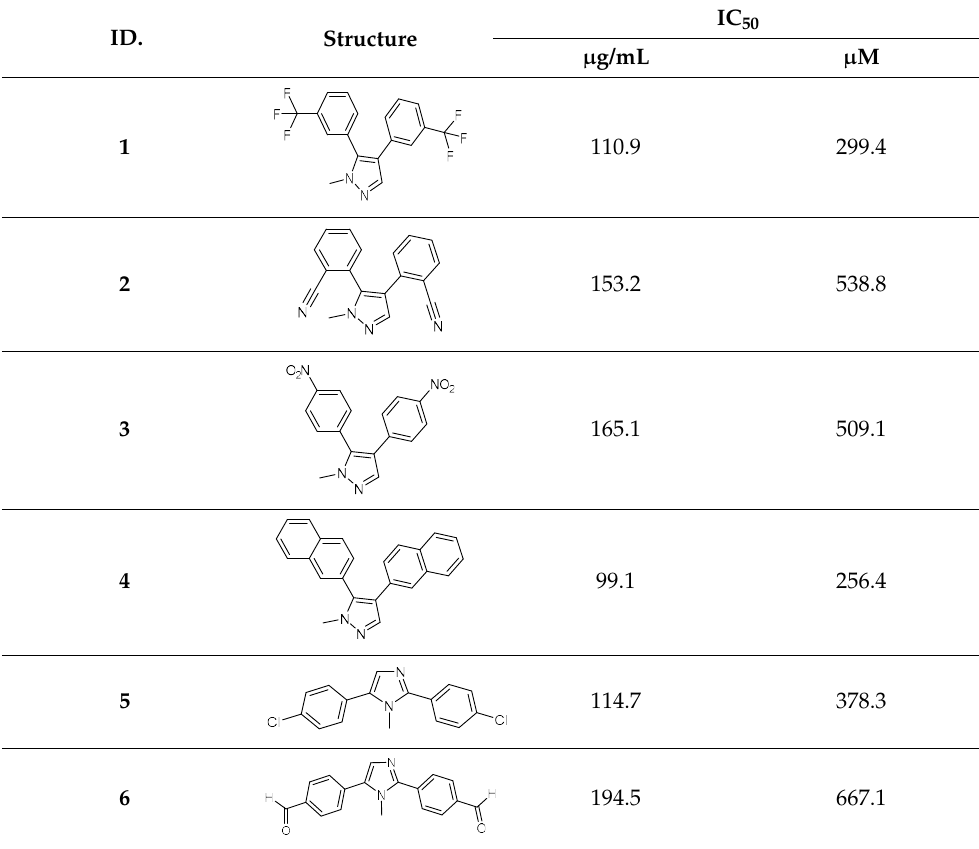
Table 2. IC 50 values of the tested βketo-enol pyridine and furan derivatives against F.o.a.